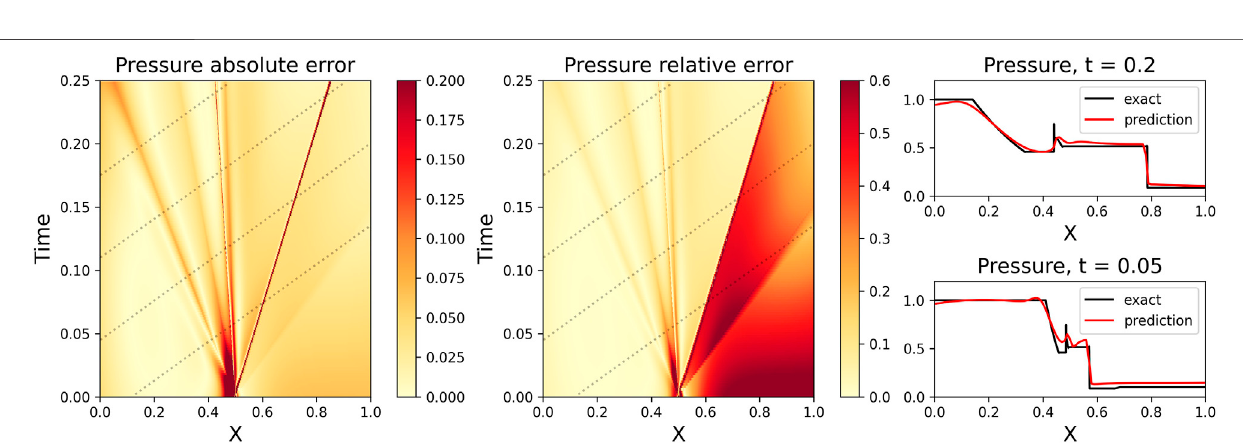
FIGURE 12 | Same as Figure 11 , except for Pressure. Random Gaussian noise (c.f. Figure 9 ) has been added to the data.